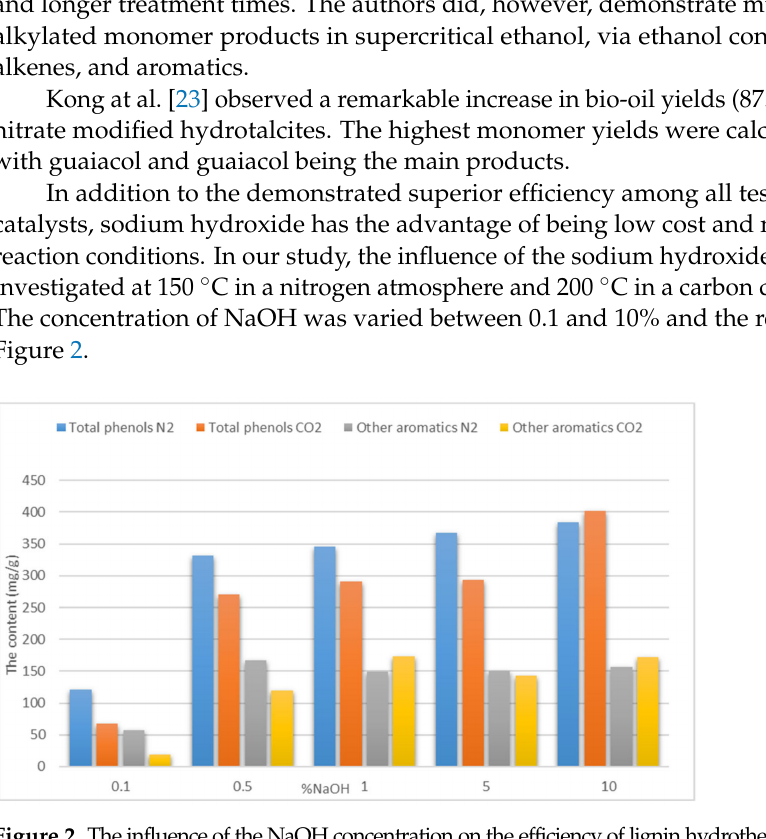
Figure 2. The influence of the NaOH concentration on the efficiency of lignin hydrothermal